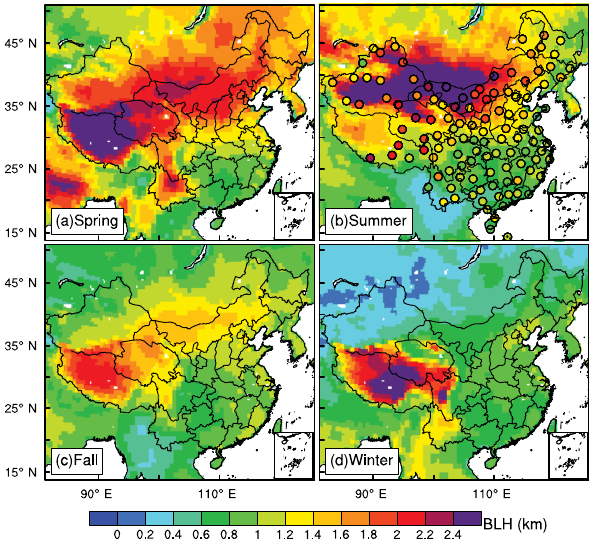
Figure 9. Same as Fig. 7, but for the spatial distribution of BLHs at 14:00BJT. Note that only the stations that have more than 30 soundings are plotted in (b) .